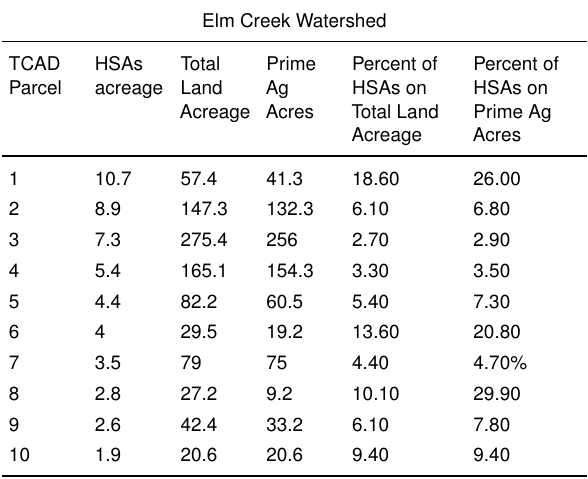
Table 3. Potential urban agriculture sites in Elm Creek watershed relative to their affiliation with TCAD